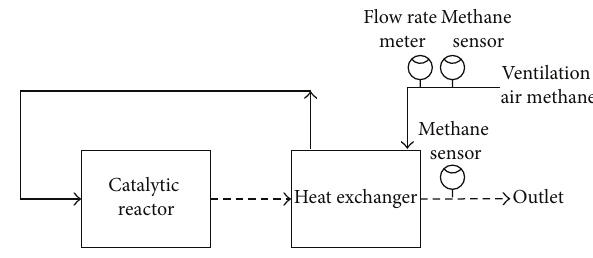
Figure 1: Preheated catalytic oxidation reactor operating principle and experimental schema.